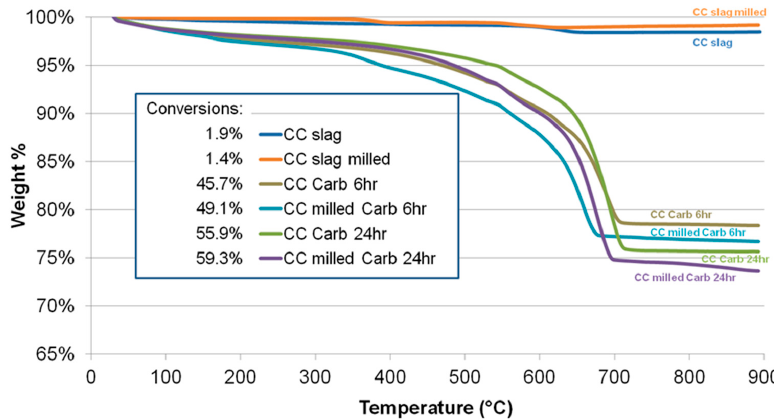
Figure 10. Pressurized slurry carbonation results of original and milled CC slag, determined by thermogravimetric analysis; CO 2 uptake calculated as weight loss between 300 and 750 °C [39].